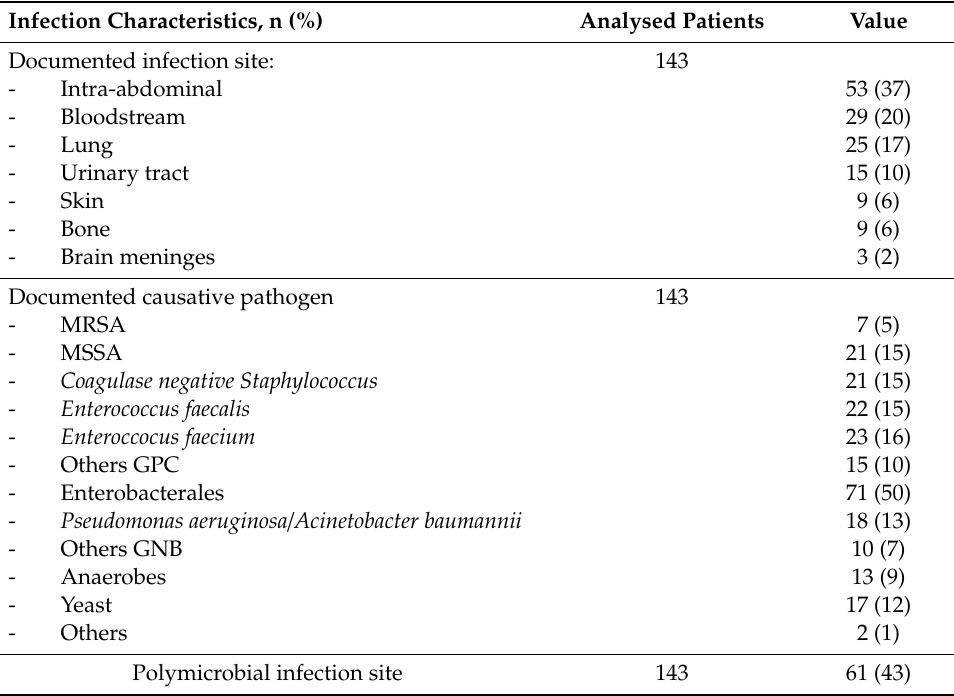
Table 3. Infection and causative pathogen